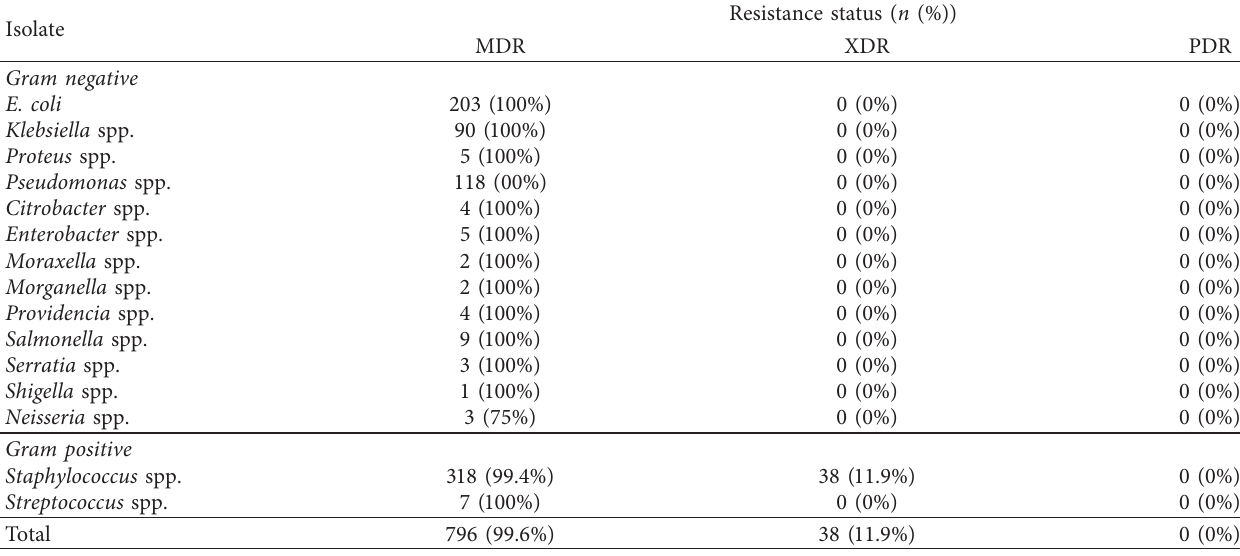
Resistance status ( n